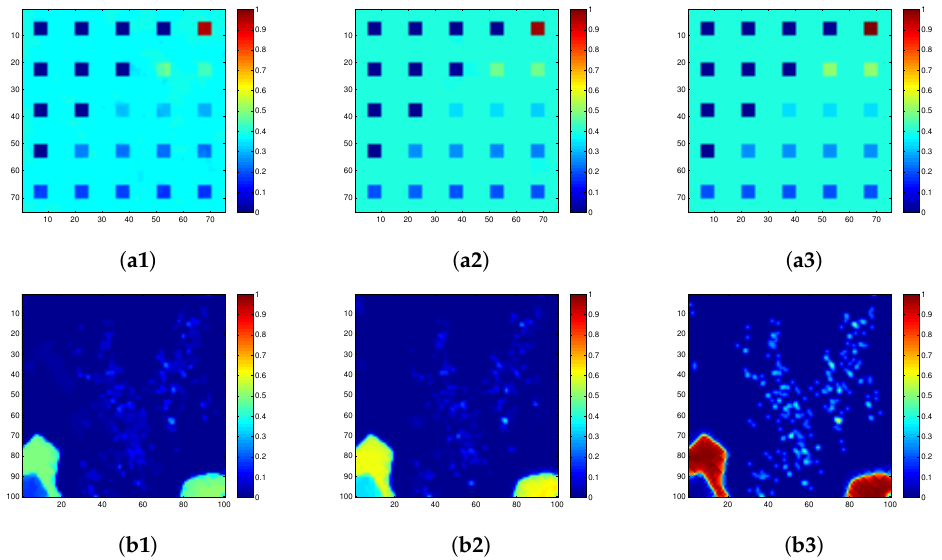
Figure 12. Effect of LA regularizer represented by improvement in RMSE when ρ > 0 for ( a ) DS data set and ( b ) FR 2 data set. ( a1 ) and ( b1 ) Before, ( a2 ) and ( b2 ) after, ( a3 ) and ( b3 ) true abundance.